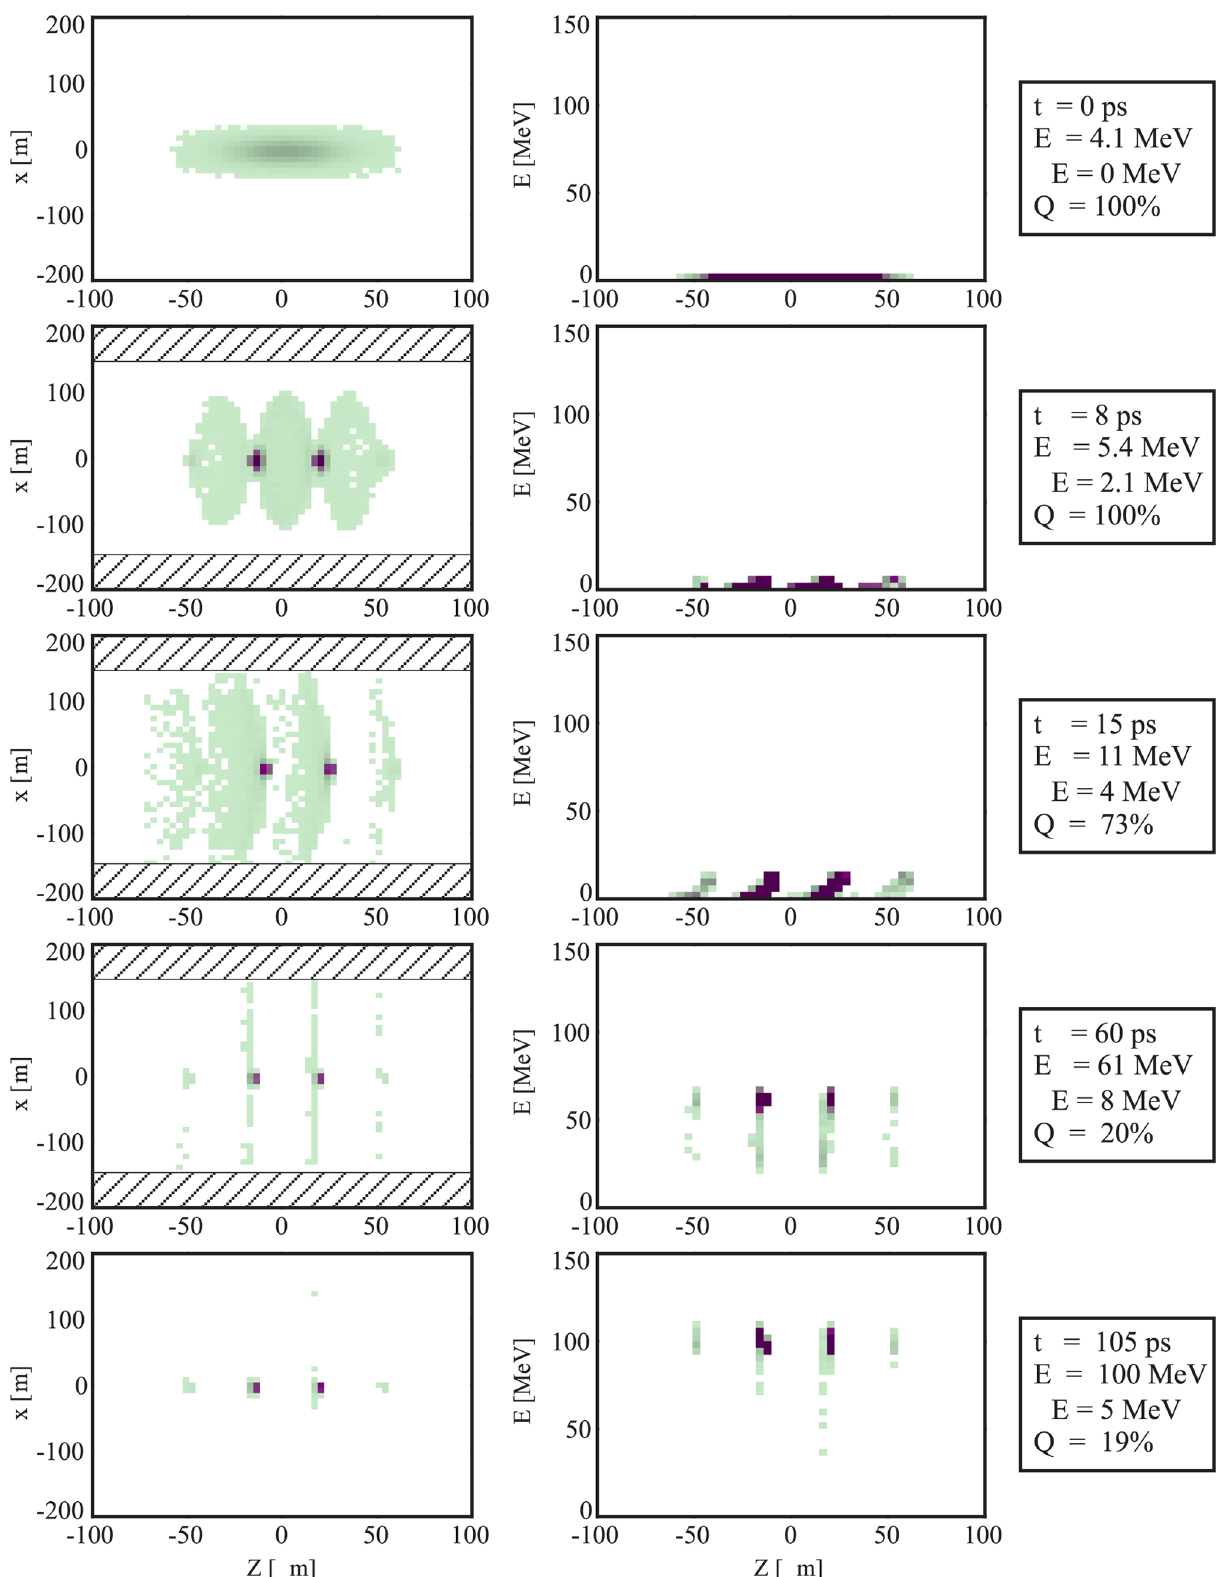
FIG. 3. (Color) Density plot of the time evolution for the radial profile (left) and energy (right) of an electron bunch injected into a plasma wave from a laser pulse with a 0 ¼ 0 : 32 . For each snapshot, the time ( t ), energy ( E ), energy spread ( (cid:5)E ), and charge ( Q ) are given on the